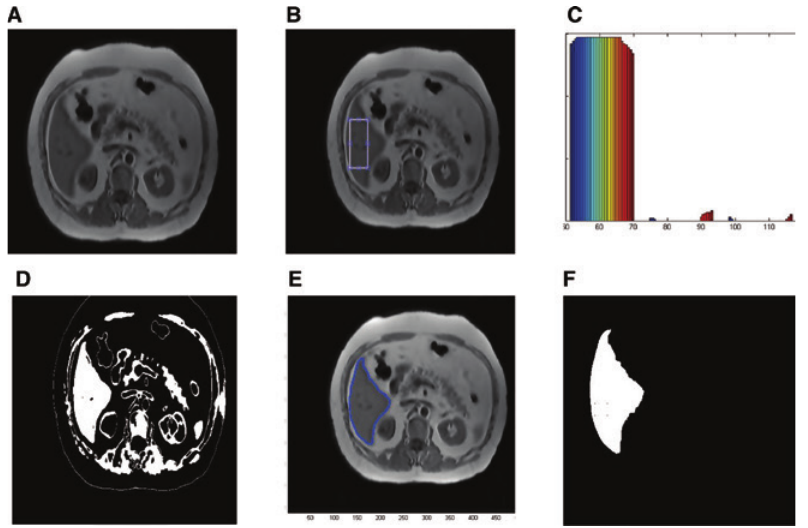
Figure 3: Illustration of liver extraction from MRI scan using proposed method. (A) Original MRI Scan Image. (B) Cropping Random Section of Liver. (C) Histogram of Cropped Liver Section. (D) Result of Histogram-Based Segmentation. (E) Liver Boundary in MRI. (F) Ground Truth Image.